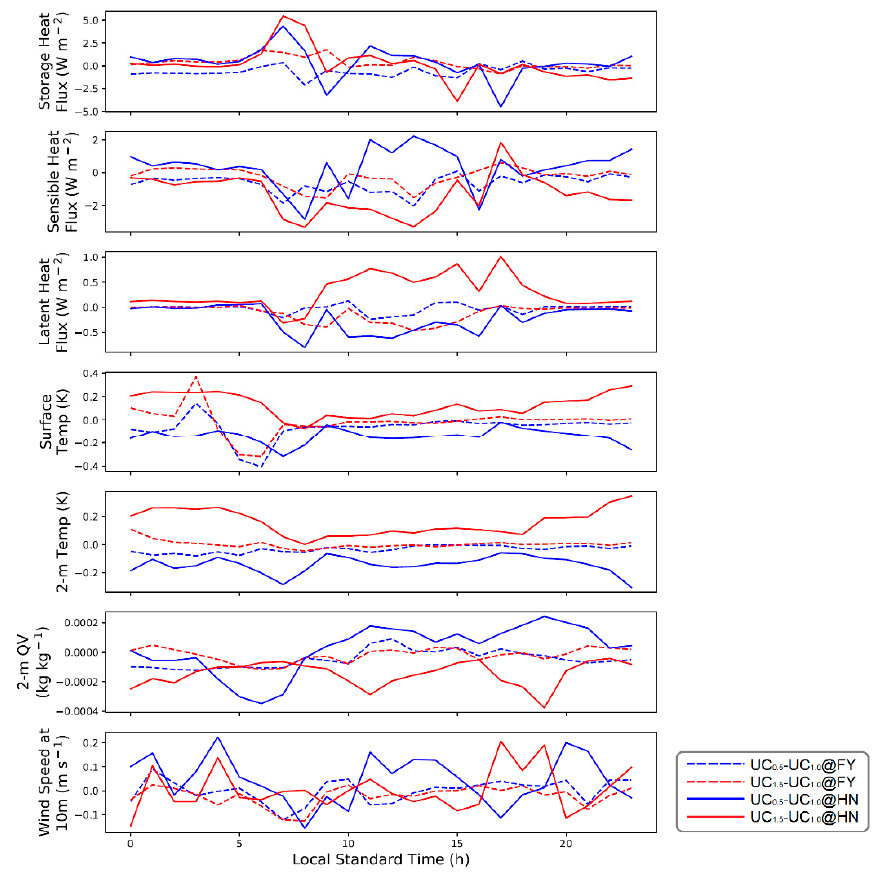
Figure 8. Temporal (2–5 July 2013 LST) and spatially-averaged differences of diurnal ( a ) storage heat flux, ( b ) surface turbulent sensible heat flux, ( c ) surface turbulent latent heat flux, ( d ) surface temperature, ( e ) 2 m air temperature, ( f ) 2 m specific humidity, and ( g ) 10 m wind speed in Fuyang (FY, dashed) and Haining (HN, solid; see Figure 1b) for differences between scenarios (section 2.5): UE 0.5 − UE 1.0 (blue) and UE 1.5 − UE 1.0 (red).